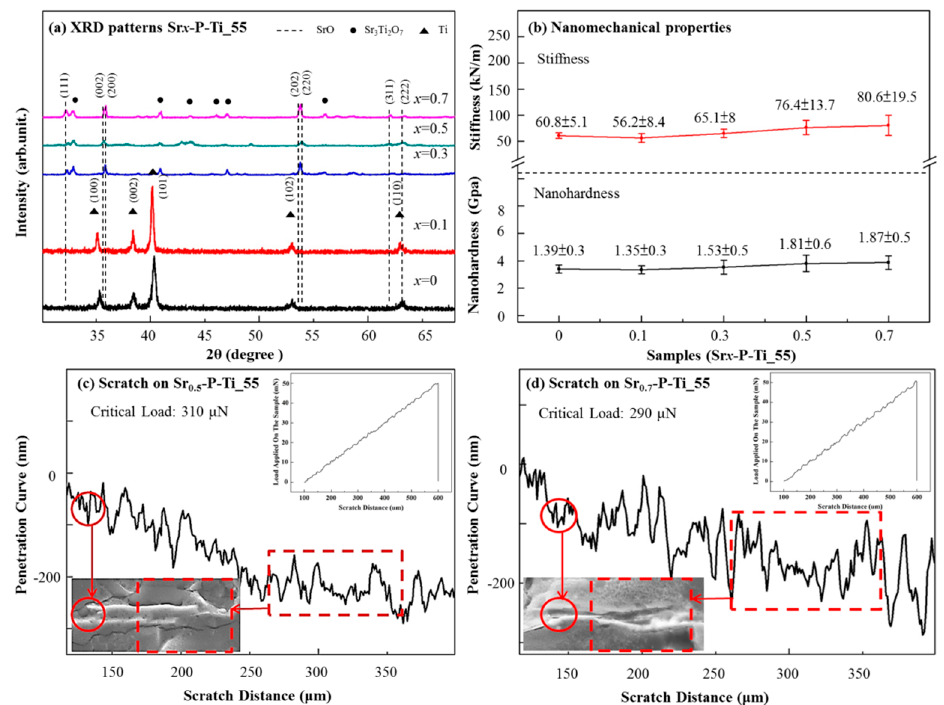
Figure 3. ( a ) XRD patterns for Sr x -P-Ti_55 with various SrO concentrations; the samples were annealed at 1000 °C for 3 h. Variations in ( b ) nanohardness and stiffness versus load on Sr x -P-Ti_55 samples were estimated at selected locations. Scratch test results for surfaces of ( c ) Sr 0.5 -P_Ti_55 and ( d ) Sr 0.7 -P_Ti_55, in which the inner figures demonstrate the scratch distance versus applied load curves for the representative samples.